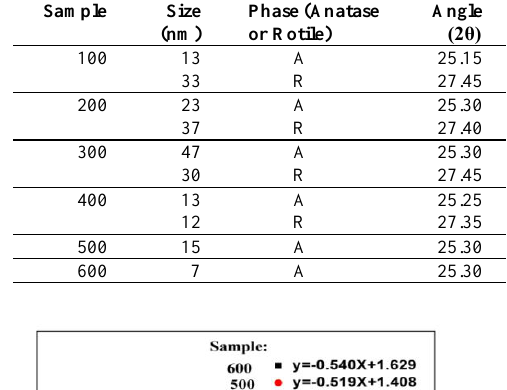
Table 3: The analysis of XRD patterns corresponds to Table 2. The size of grain is derived by using Scherer’s equation .The phase is also extracted from database of XRD patterns (A= Anatase, R= Rutile). The angle (2θ) corresponds to more insensitive peak relevant to anatase or rutile phase.